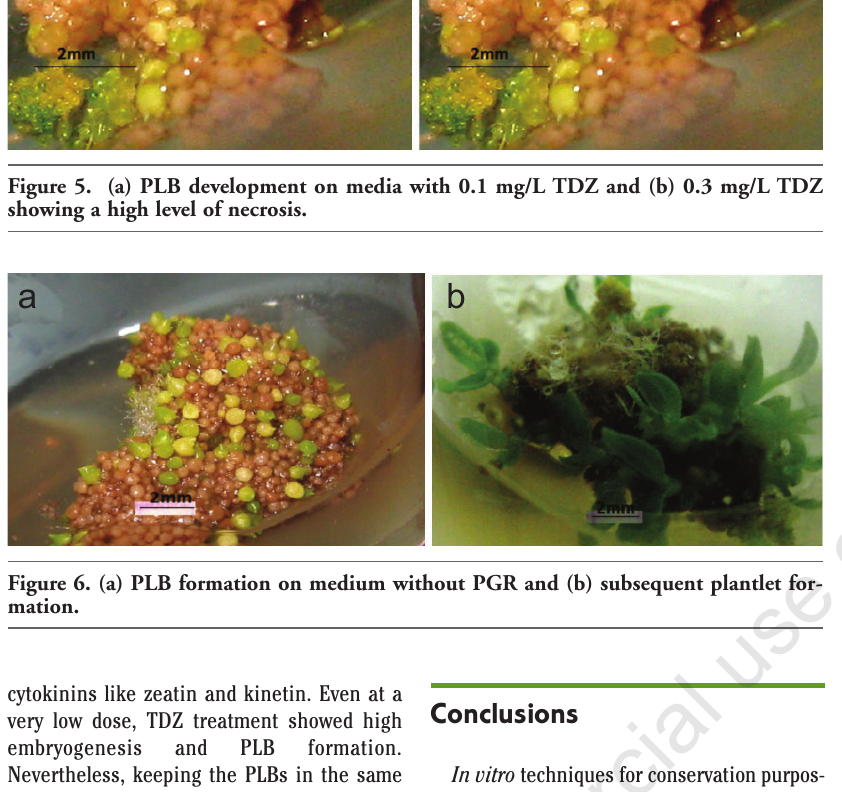
cytokinins like zeatin and kinetin. Even at a